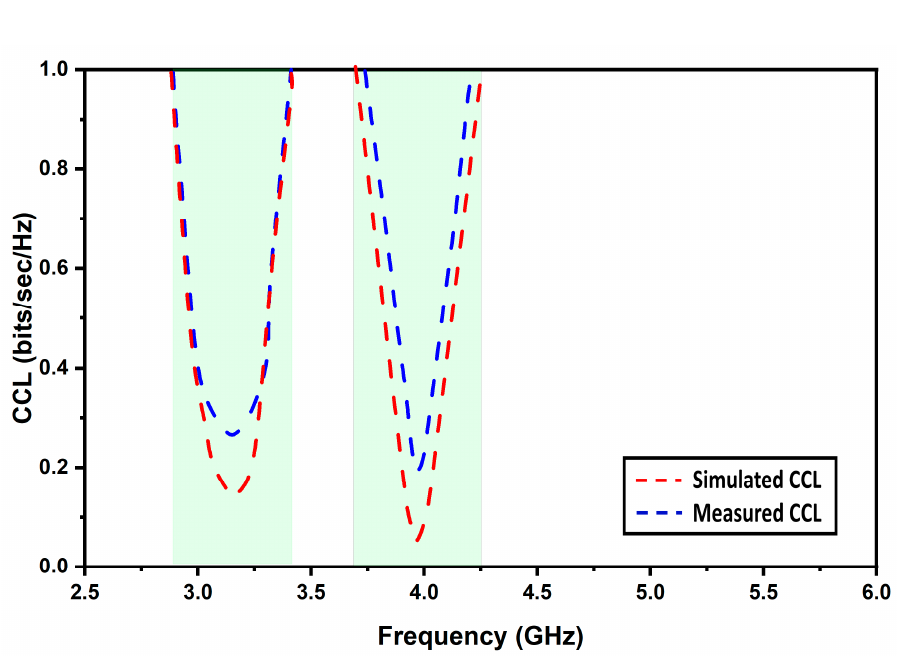
Figure 12. Simulated and measured CCL.